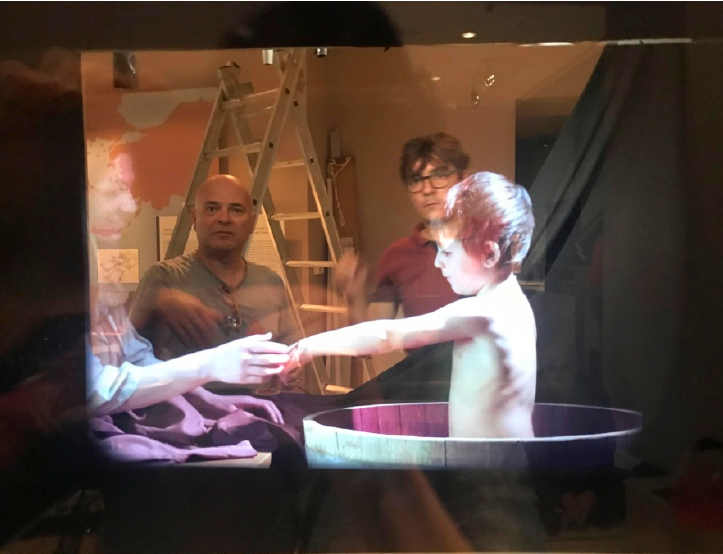
Figure 23. Holographic showcase with transparent background during the installation set up in the Byzantine and Christian Museum of Athens (CEMEC project). Virtual characters are in real scale.